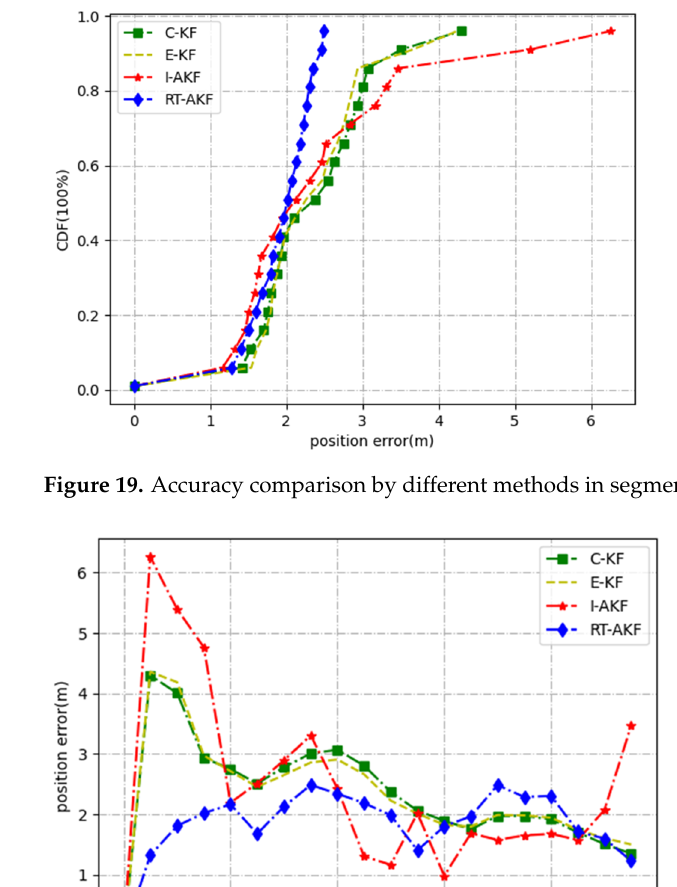
21 of 24 Figure 18. The positioning errors of GNSS/INS tightly coupled integrated by different methods in segment #6. Road segment #7 was a straight road shaded by greenery. The mean error obtained